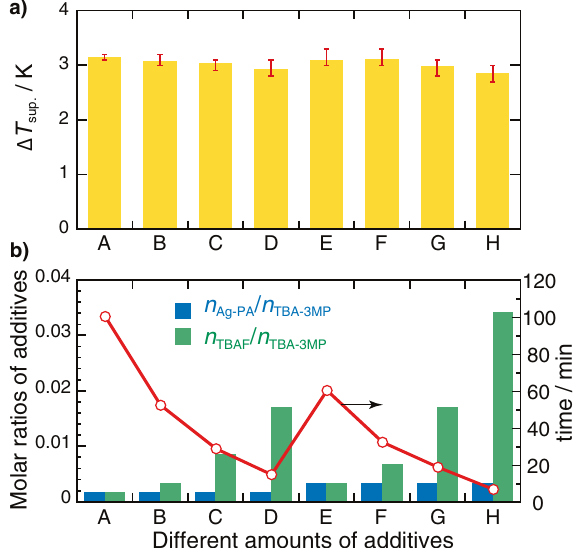
Fig. 2 Effect of the amount of additives. a The degree of supercooling. Error bars represent standard deviation. b The time for crystallization to be completed. Ag-PA and TBAF were added as additives to the TBA-3MP aqueous solution with the mass fraction ( w TBA-3MP = 0.42). The amount ( n TBA-3MP ) of TBA-3MP included in the aqueous solution is 1.4 mmol. The higher the ratio of TBAF was, the faster the crystallization was completed, whereas the degree of supercooling was almost independent of